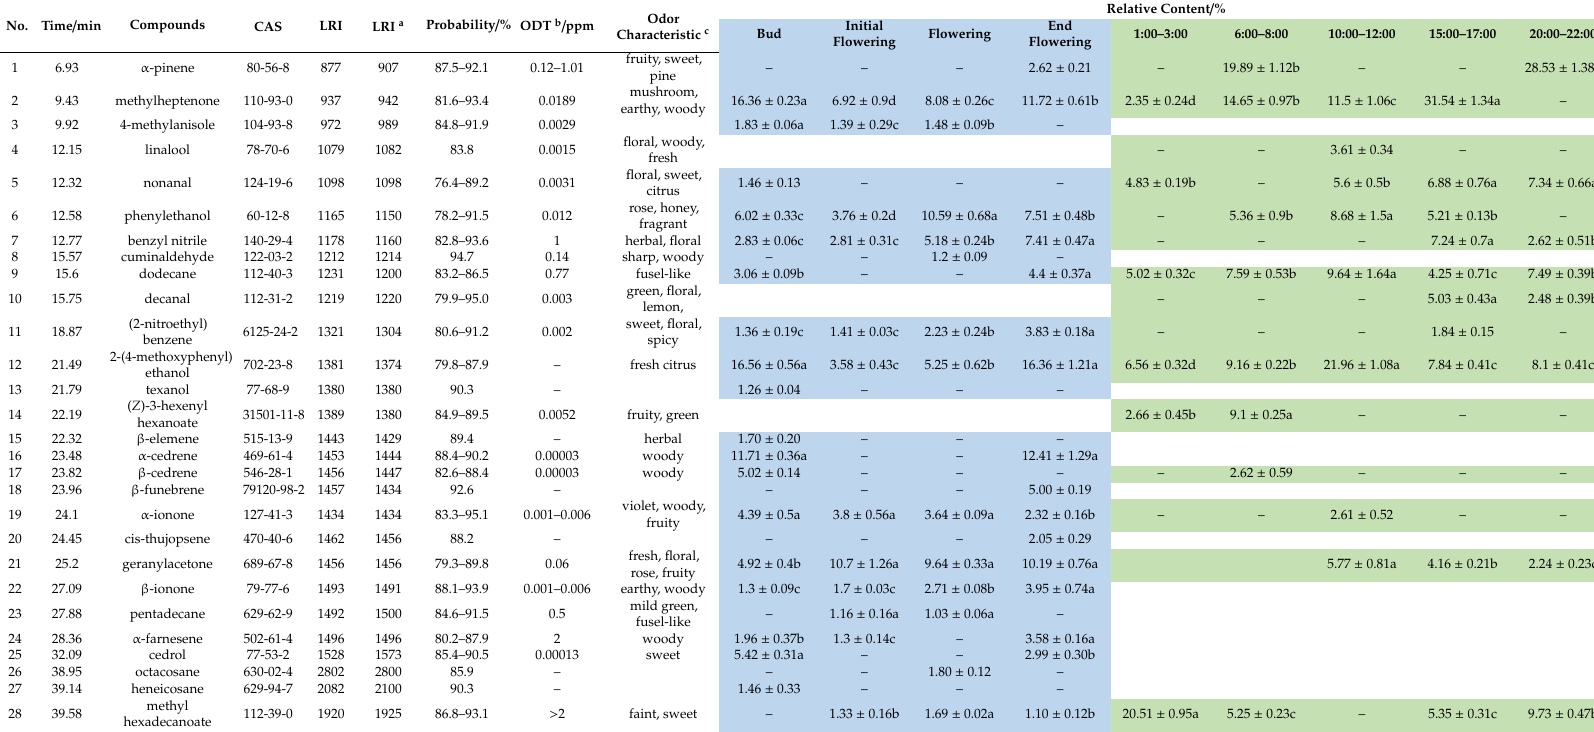
Table 1. Volatile compounds detected in M . ioensis “Prairie Rose” flowers at di ff erent flowering stages and during the day and night using SPME-GC-MS. Please note that all identifications are tentative since no direct comparison with authentic standard compounds was